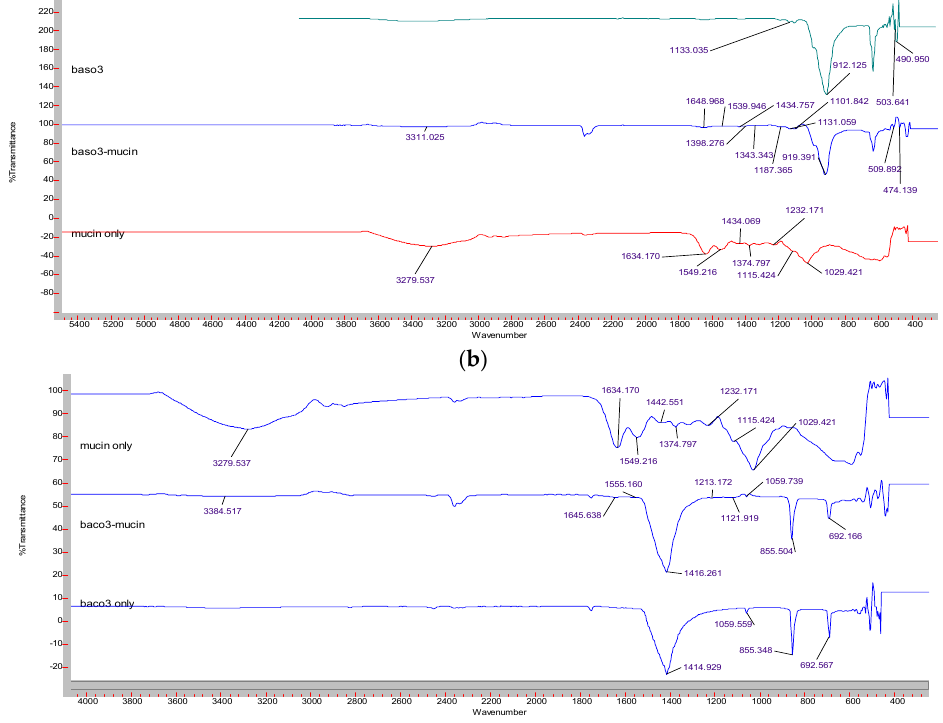
Figure 11. FT-IR spectrum showing mucin adhesion to three different Ba salt particles. Particle only, mucin only, and particles adhered to mucin were analyzed with FT-IR. ( a ) The spectrum for BaSO 4 particle only, free mucin, and BaSO 4 -mucin complex. ( b ) The spectrum for BaSO 3 particle only, free mucin, and BaSO 3 -mucin complex. ( c ) The spectrum for BaCO 3 particle only, free mucin, and BaCO 3 -mucin complex.